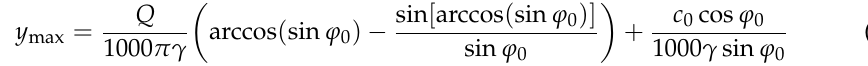
where θ = θ 1 + θ 2 . From Equation (6), θ = arccos (sin φ 0 ). Therefore, the maximum depth y max is: